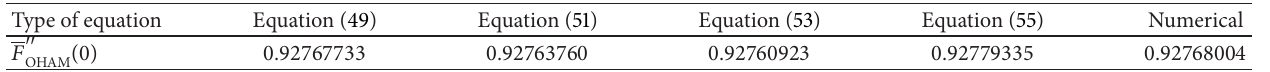
󸀠󸀠 (0) obtained by means of OHAM and numerical results for 𝛽 = 1/2 .